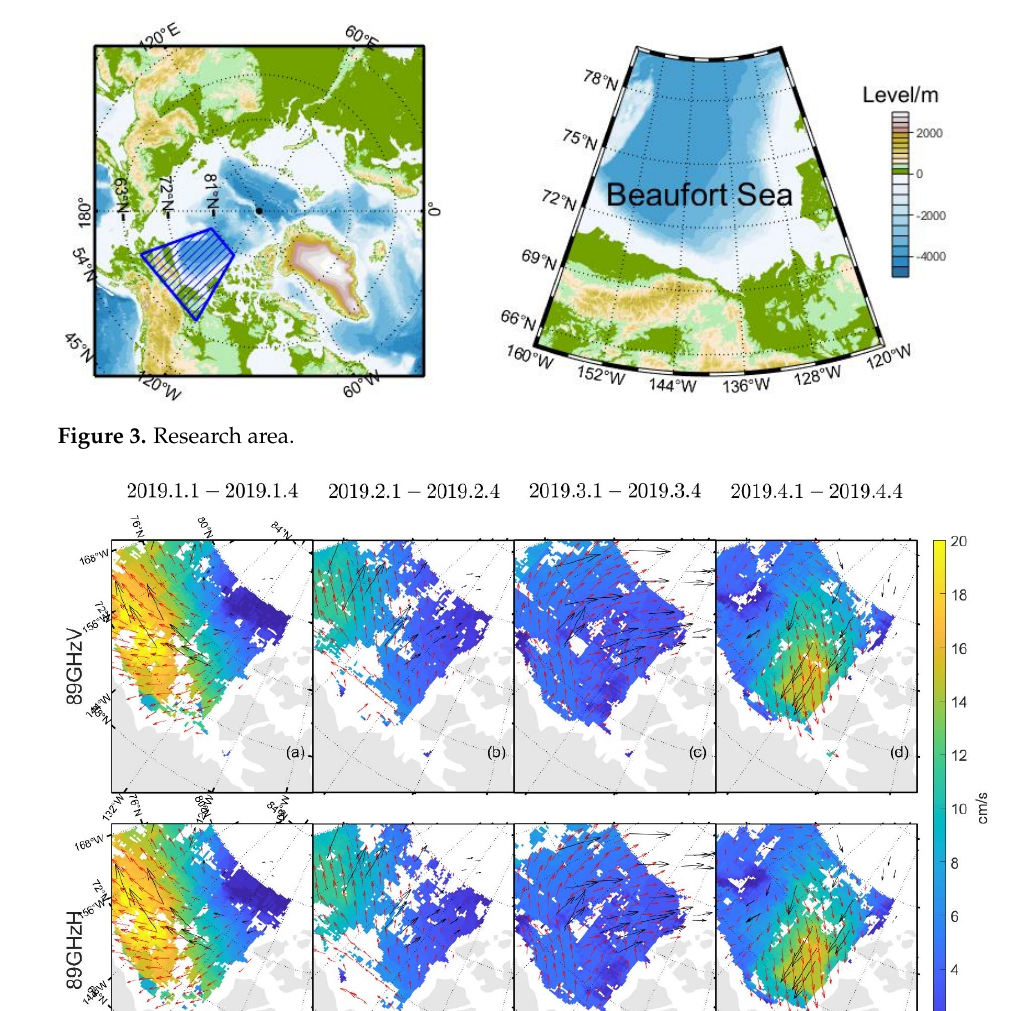
Figure 3. Research area.